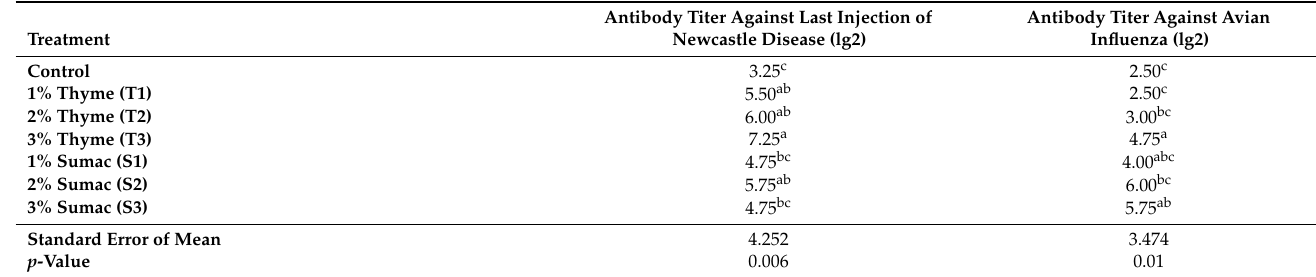
Table 7. Immune response mean ( ± SEM) after vaccination (influenza and Newcastle) of Ross 308 broilers fed diets containing 0, 1, 2, and 3% thyme (T3) and sumac from days 29–42.